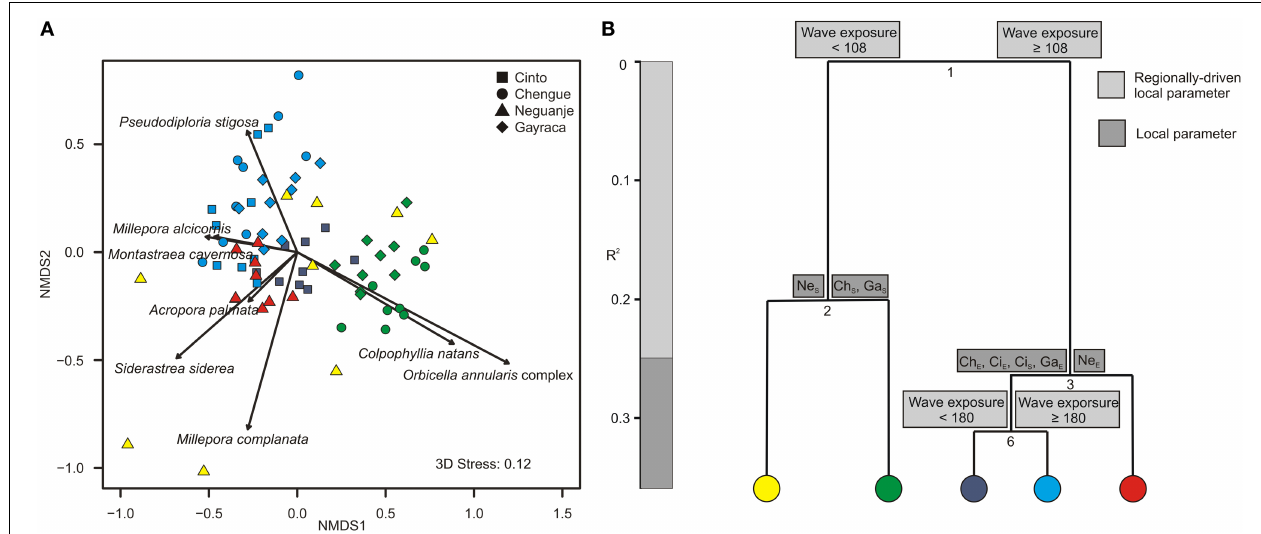
FIGURE4|Graphical representation of (A) non-metric multidimensional scaling (NMDS) and (B) multivariate regression tree analysis (MRT) for coral assemblages in Tayrona National Natural Park. (A) Variation in coral assemblages shown for the first two axes from a NMDS and the relative contribution of each coral species significantly accounting for the variation (arrows). Colors indicate groupings according to the coloring of MRT leafs. (B) MRT and associated physical and environmental